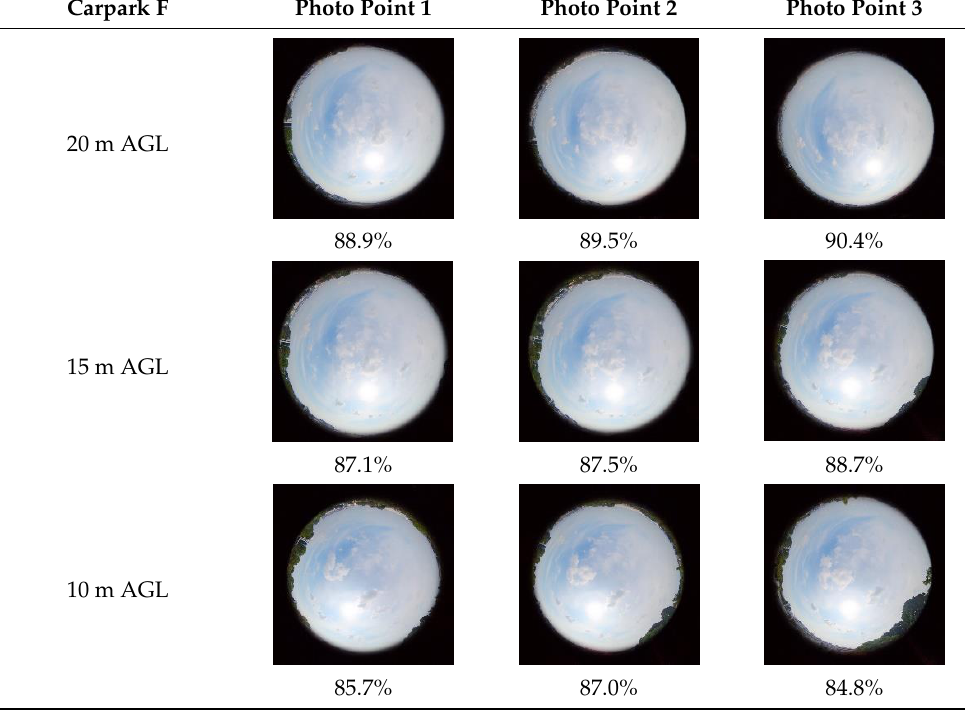
Figure 14. Graph of EPH vs. Latitudinal Value at Carpark F.